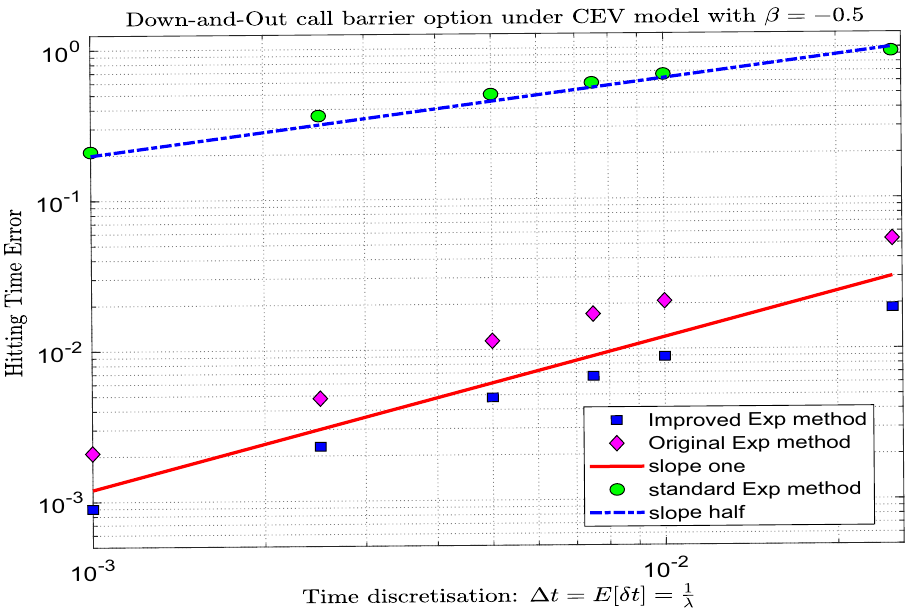
Fig. 1 Plots of the hitting time error calculated using the standard exponential timestepping method, the original exponential method and the improved exponential time stepping algorithm against the discretization parameter (cid:7) t for the down-and-out call barrier option under CEV model. The parameters are fixed as the volatility parameter at initial time σ 0 = 0 . 25, the dividend q = 0, the risk-free interest rate r = 0 . 1, the current value of the option S 0 = 100, the strike price K = 95, the barrier H = 90, the elasticity of the local volatility β = − 0 . 5, and the expiration time T = 0 . 5. The theoretical value is 10 . 6013 and the averages are taken over M = 10 7 realizations